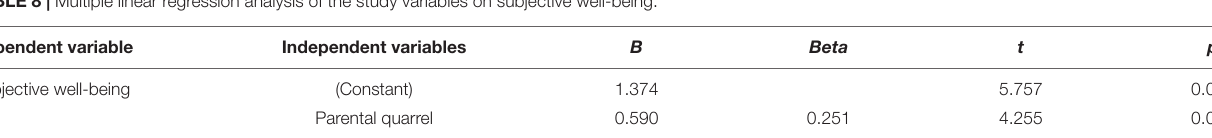
TABLE 8 | Multiple linear regression analysis of the study variables on subjective